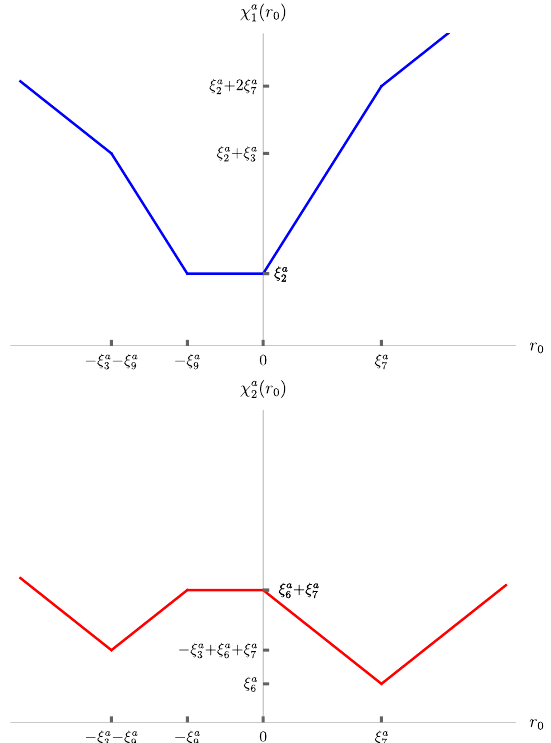
Figure 19: IIA profiles for the vertical reduction of resolution